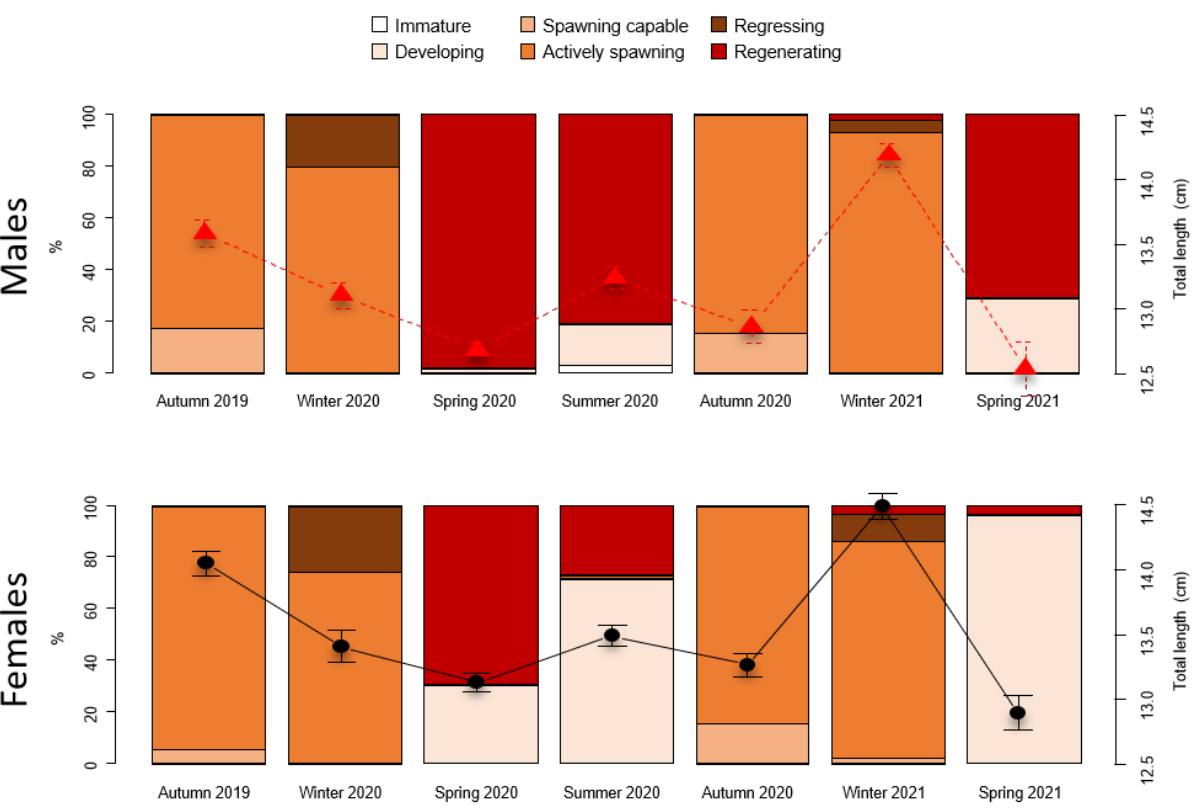
Figure 5. Seasonal analysis of the European sardine’s ( S. pilchardus ) reproductive developmental stages in the Gulf of Trieste (North Adriatic). Graphs are presented by sex and reproductive developmental stage according to the classification of Brown-Peterson et al. [47]. The total length (cm) is also reflected for both sexes.